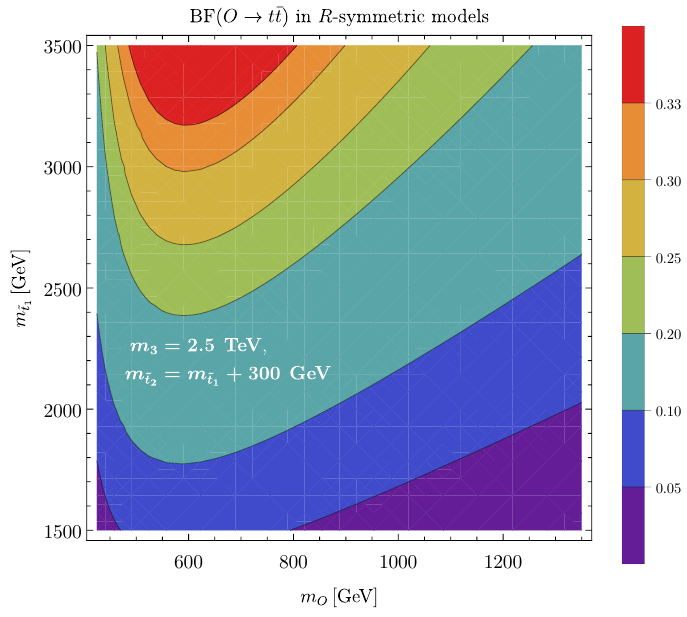
Figure 3 . Branching fraction BF ( O → t ¯ t ) of the scalar sgluon to top quark pairs in Dirac gaugino models. In this plane, the Dirac gluino mass is fixed at m 3 = 2.5 TeV and the splitting between stop squarks is 300 GeV. The squarks must become quite heavy for the branching fraction to exceed 40%. a U(1) symmetry that does not commute with supersymmetry, in order to forbid